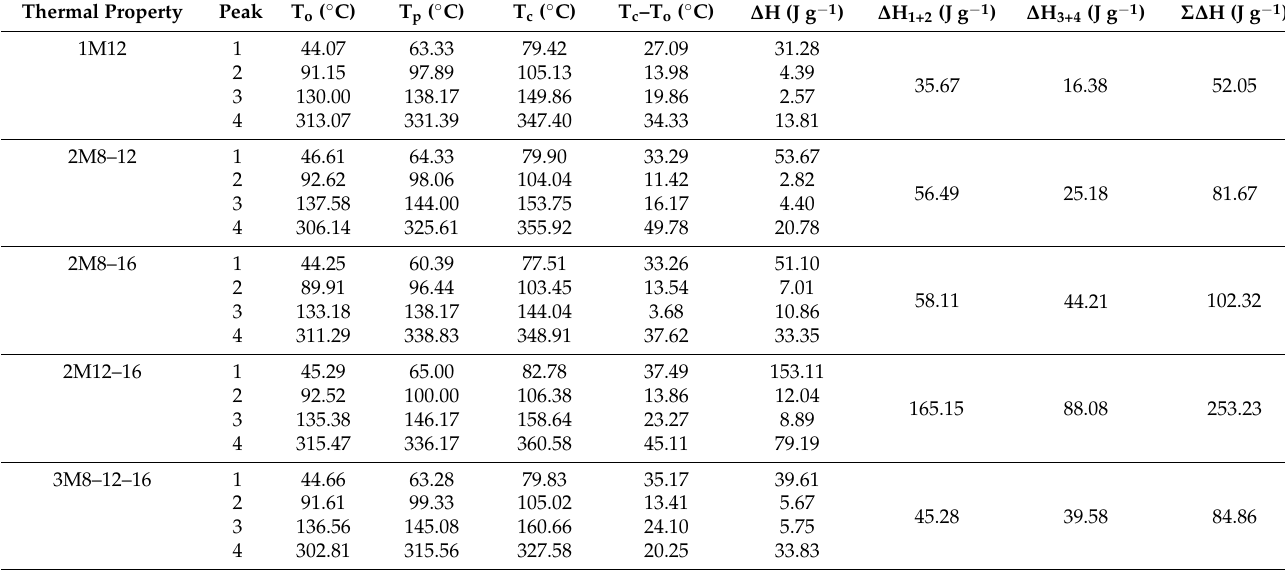
Table 3. Thermal properties for detecting available and unavailable nutrients present in feces of hawksbill sea turtle subjected to feeding at various frequencies. The sampling was done at the end of the 8-week experiment.